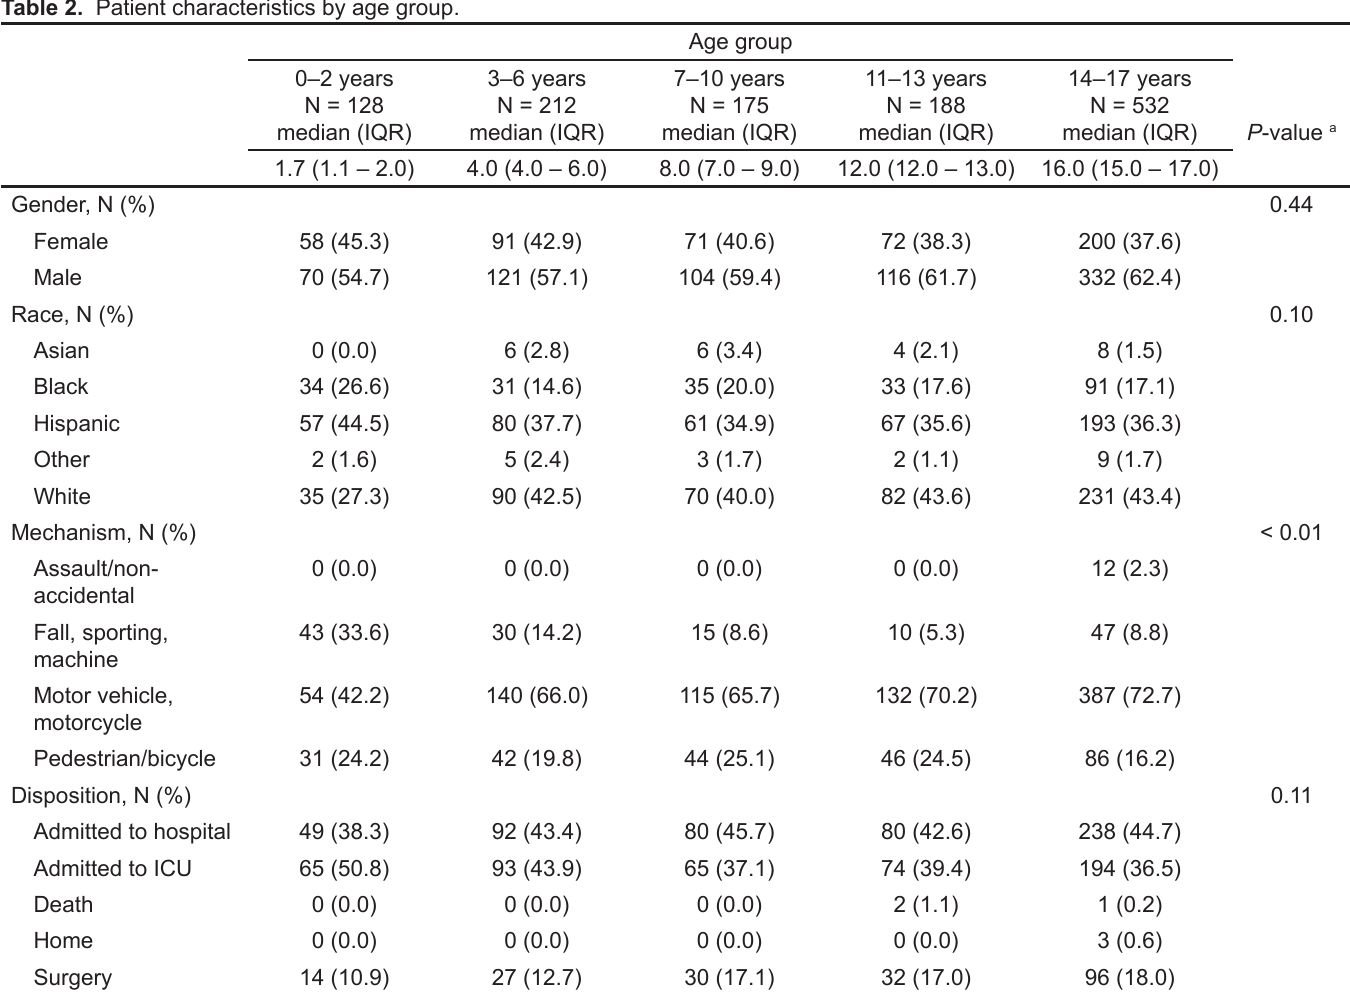
Table 2. Patient characteristics by age